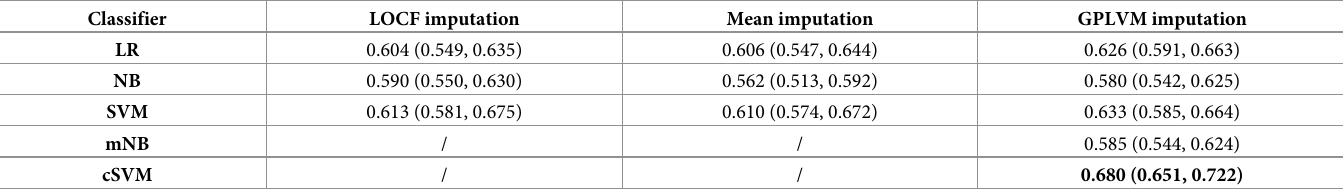
Table 4. AUC using different combinations of classifiers and imputation methods.